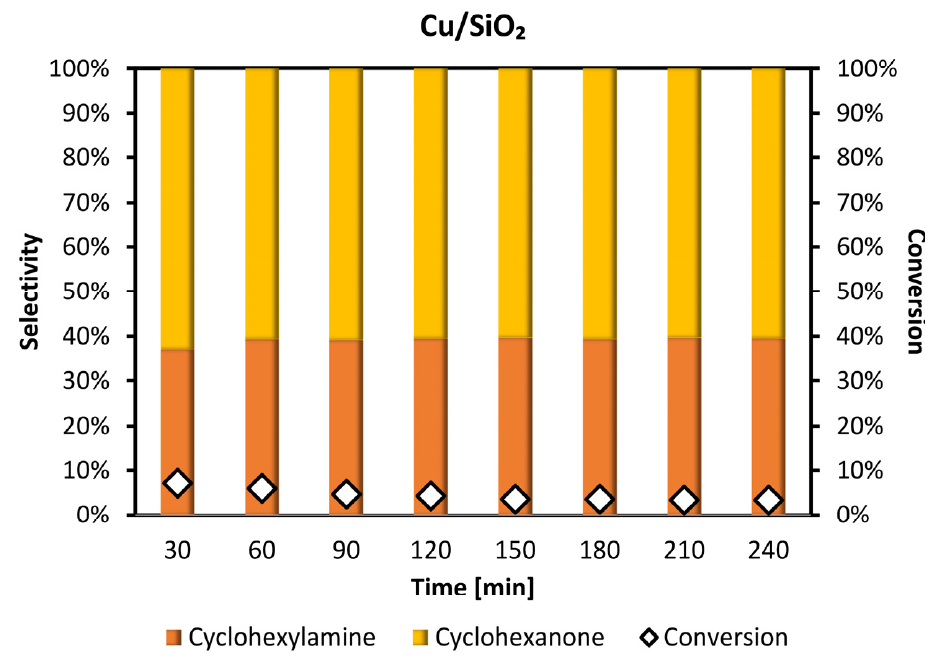
11 of 19 . Figure 13. Stability test of CuCo(3:1)/SiO 2 in catalytic hydrogenation of nitrocyclohexane in liquid flow conditions (5 bar, 75 °C). 2.5.2. Catalytic Hydrogenation of Nitrocyclohexane in Gas Flow Conditions under At- mospheric Pressure Each catalyst tested in the liquid continuous-flow reactor was also tested in gas flow conditions (Figures 14–18). Despite the differences between these two catalytic reactors and different reaction conditions, all the catalysts maintained similar selectivity to specific products.